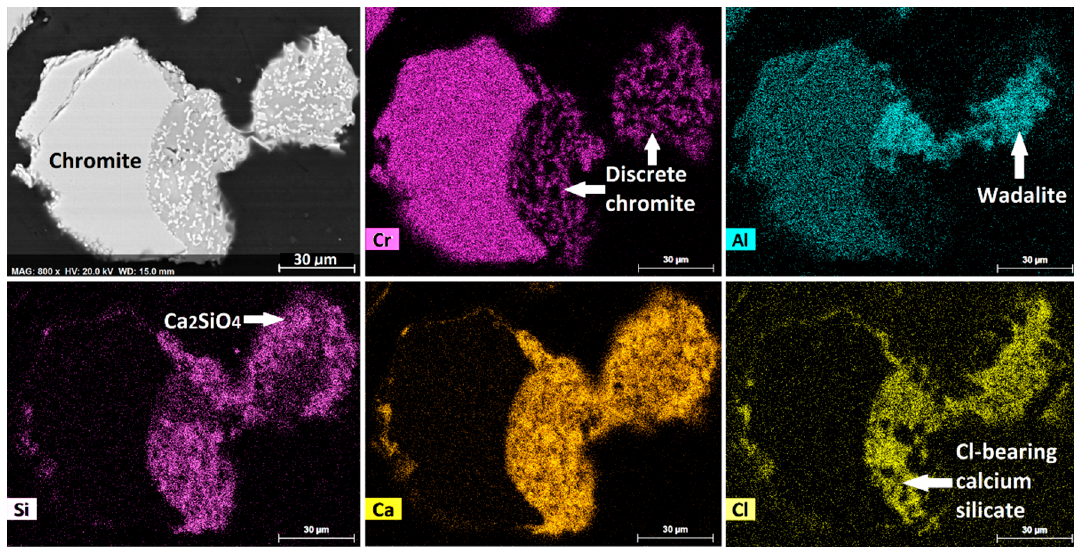
Figure 16. BSE and elemental mapping images illustrating the presence of residual chromite particles disseminated in the secondary silicates (i.e., wadalite, Ca 2 SiO 4 , and a Cl-bearing calcium silicate).